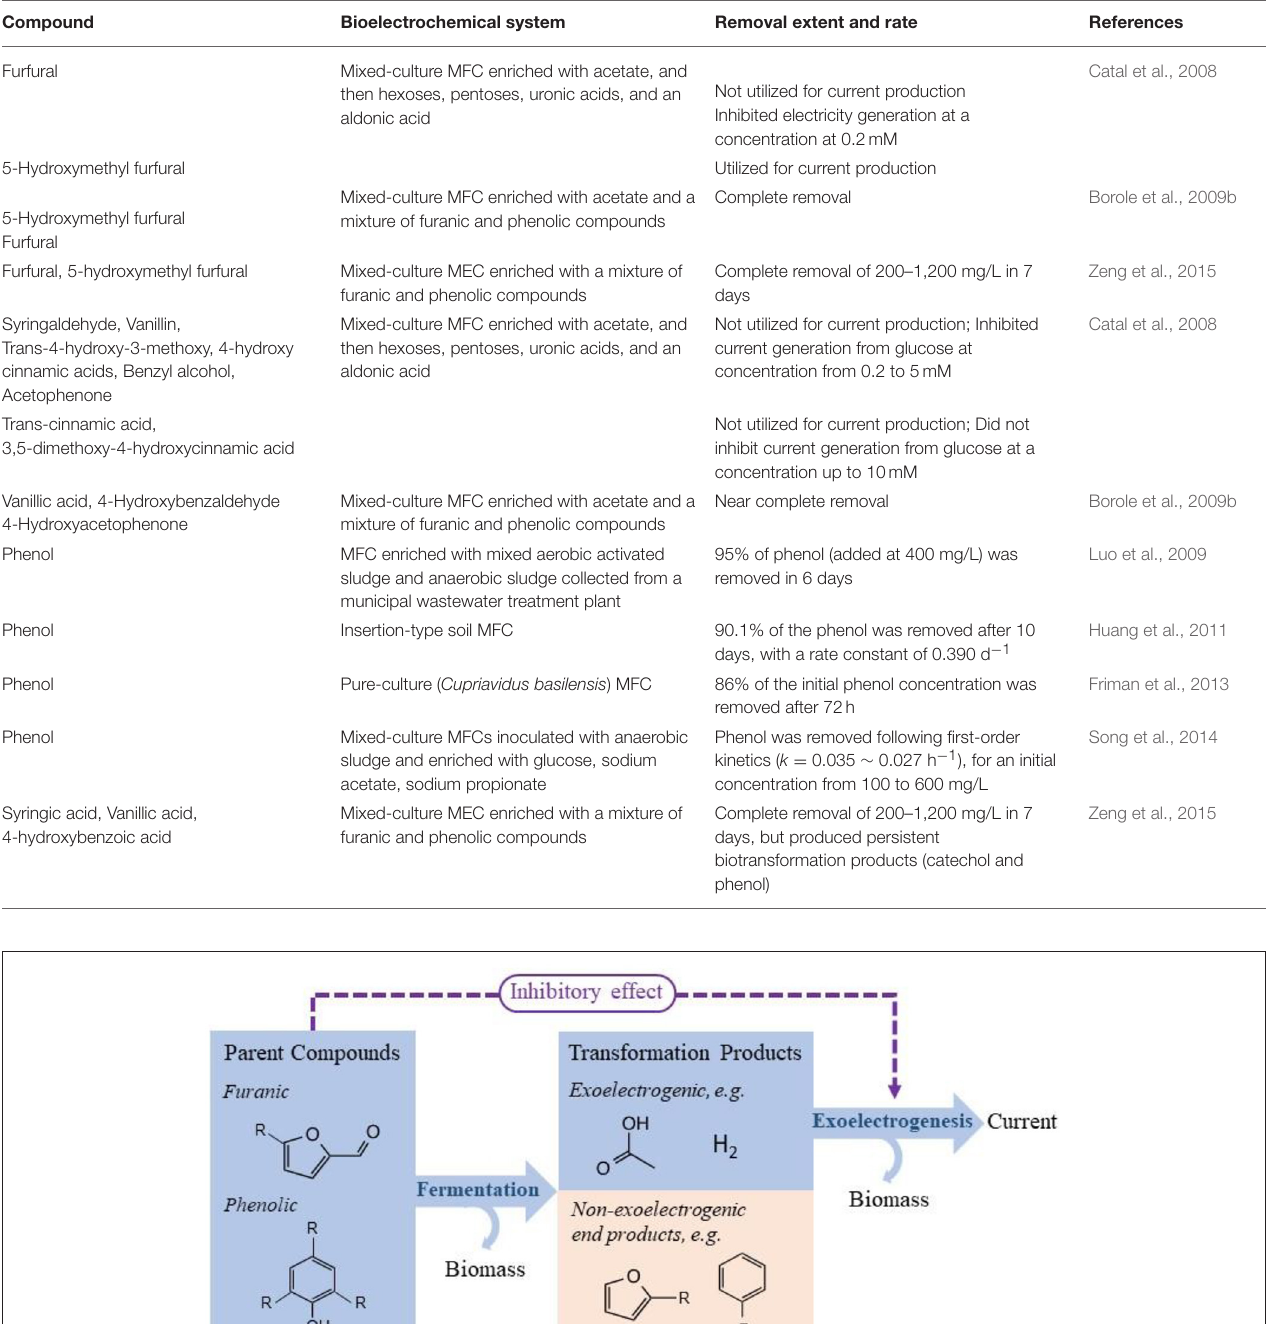
TABLE 3 | Furanic and phenolic compounds tested in bioelectrochemical systems.